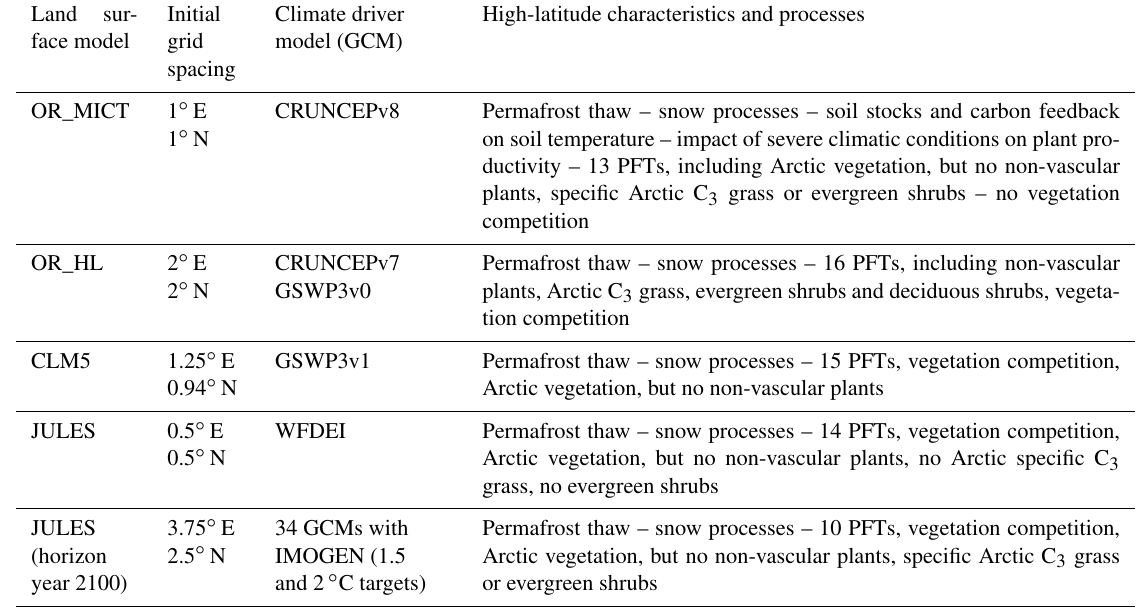
Table 1. Summary of the main characteristics of the four LSMs (for details see references) analysed for the historical period 1997–2013 and the forecasts to 2100 with JULES. Acronyms and references for the GCM drivers are given in the associated references to the LSMs. Land